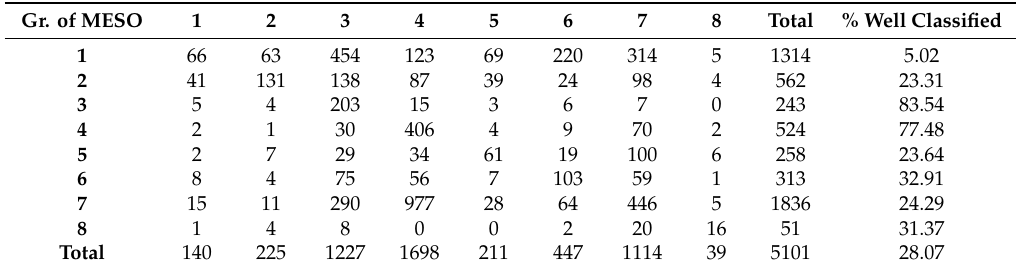
Table 4. Confusion matrix of the discriminant analysis performed on the groups of MESO. Gr. of MESO